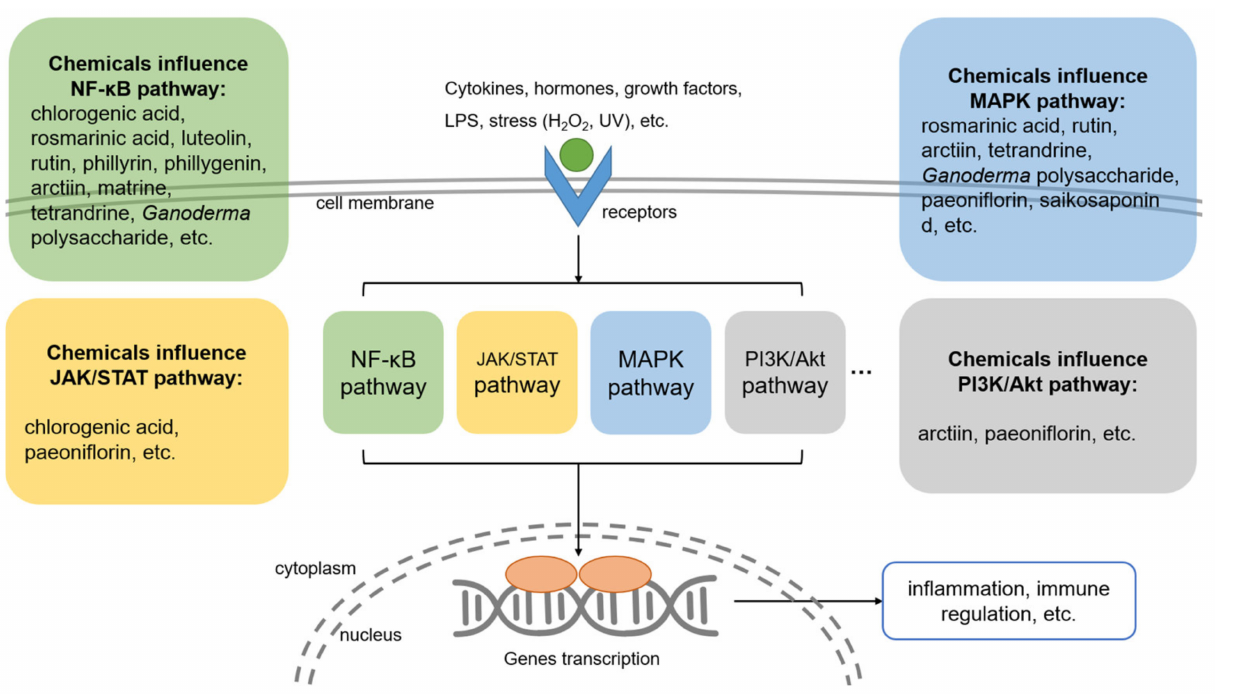
Figure 3. Immunomodulatory mechanisms of some TCM ingredients. When cytokines, hormones, growth factors, or LPS bind to the receptors on the cell membrane, down-stream pathways are stimulated. Transcription factors that are regulated by these pathways enter the nucleus and promote the expression of inflammatory factors or immunomodulatory factors. TCM ingredients affect these pathways and thereby regulate inflammatory processes as well as the immune